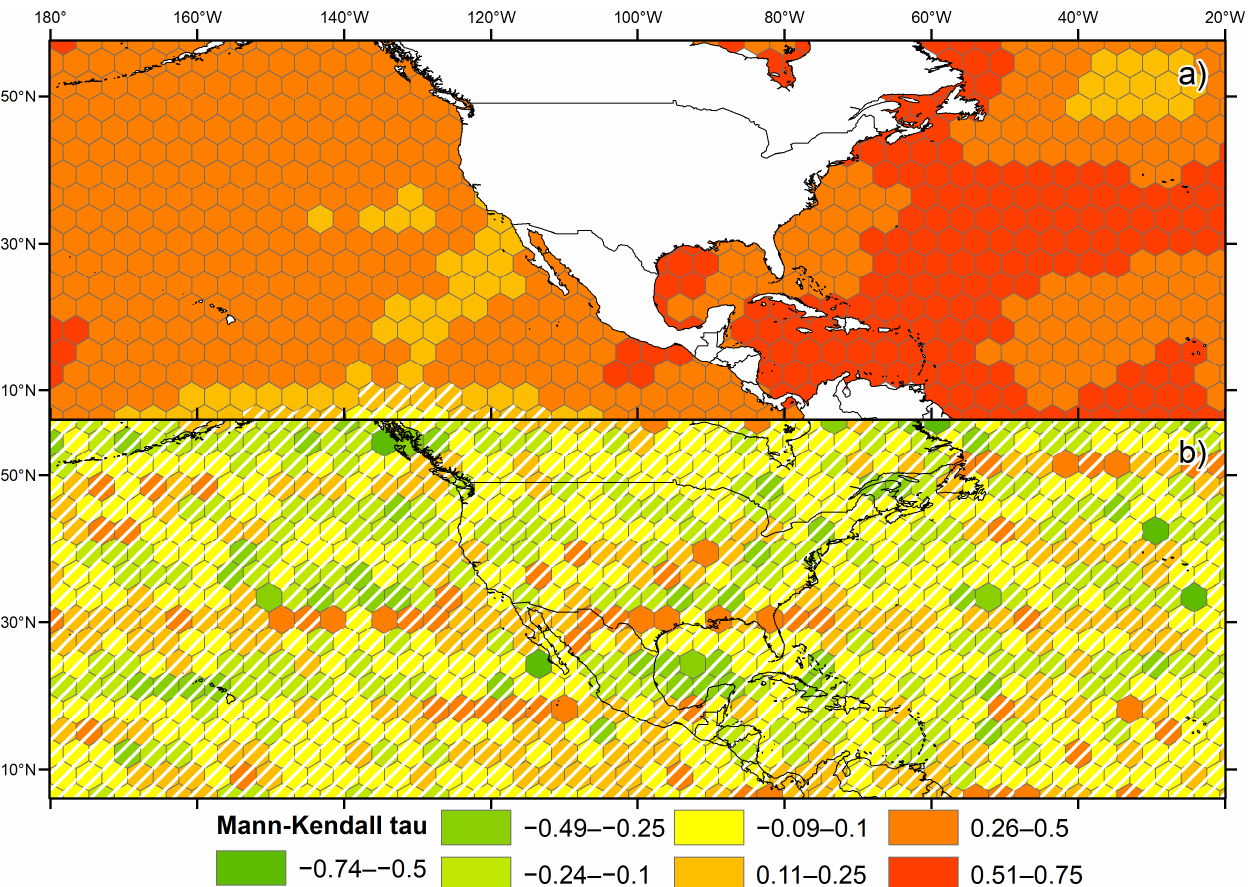
Figure 6. Spatial trends in: ( a ) SST; and ( b ) VWS calculated from 1970 to 2021. Cells hatched with white lines have a non-significant trend.